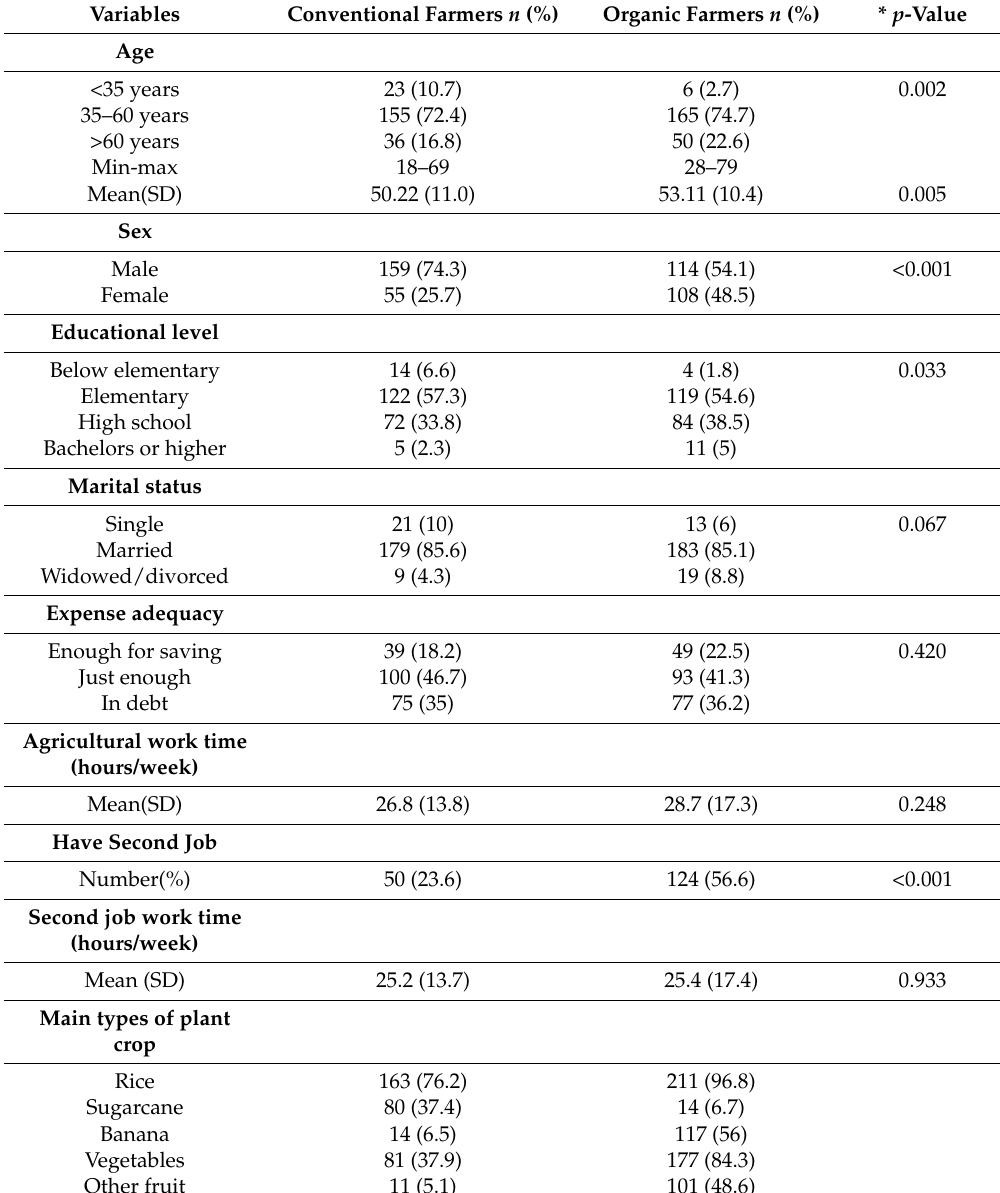
Table 1. Demographic characteristic of conventional farmers ( n = 214) and organic farmers ( n =